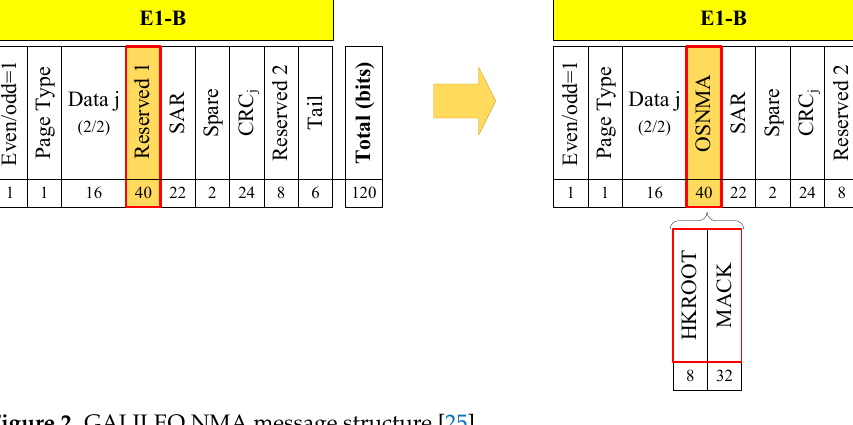
Figure 2. GALILEO NMA message structure [25].